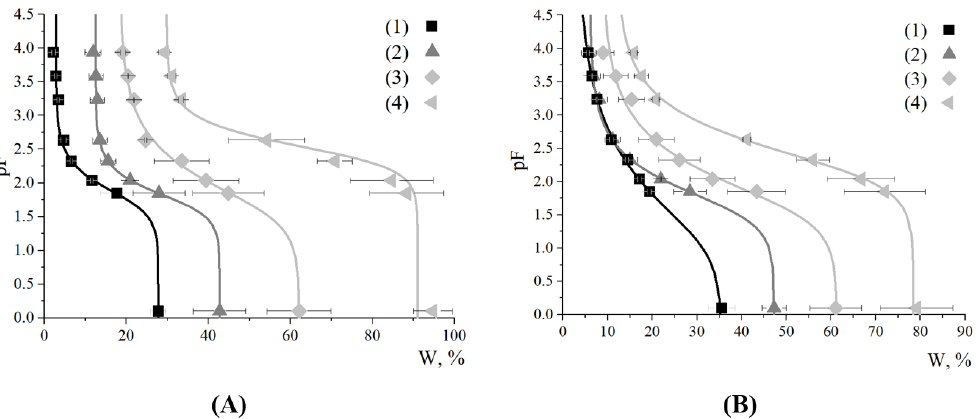
Figure 4. Water retention curves for sand ( A ) and soil ( B ) with different contents of ACP#. ( A ) Sand: control (1); 0.2 (2), 0.5 (3), and 1 wt.% of ACP# (4). ( B ) Soil: control (1); 0.2 (2), 0.5 (3), and 1 wt.% of ACP# (4). Samples saturated with 0.001 M phosphate buffer, pH 6.5.